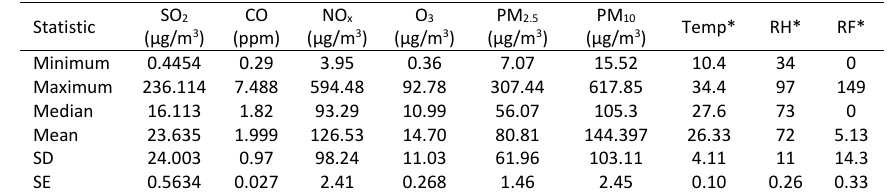
Table 1: Summary statistic of criteria air pollutants based on daily mean and meteorological parameters during January 2013 to December 2017 in Dhaka city